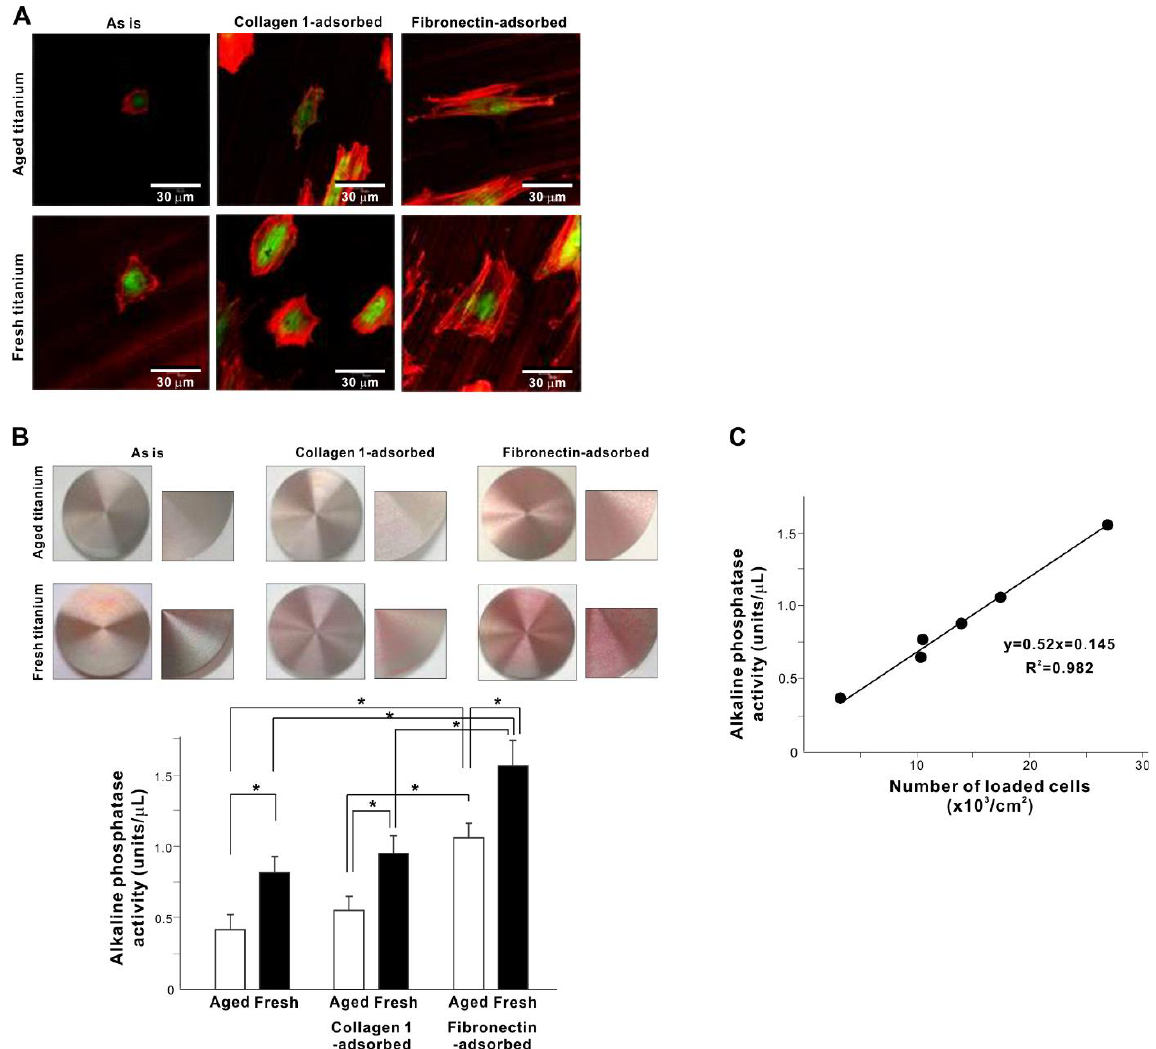
Figure 5. Behavior and function of osteoblasts loaded on various titanium surfaces. ( A ) Confocal fluorescent microscopy images of osteoblasts after a 3-h incubation dual-stained for cytoskeletal actin filaments (red) and focal adhesion protein vinculin (green). ( B ) Alkaline phosphatase (ALP) activity evaluated after three hours of loading onto titanium surfaces. The results of ALP chemical detection are shown in the histogram, with representative ALP-stained images for visual confirmation. * p < 0.05, statistically significant difference between two different surfaces. ( C ) Verification of the functional phenotype of loaded osteoblasts. A plot of the number of loaded osteoblasts and ALP activity with the correlation coefficient (R 2 ).